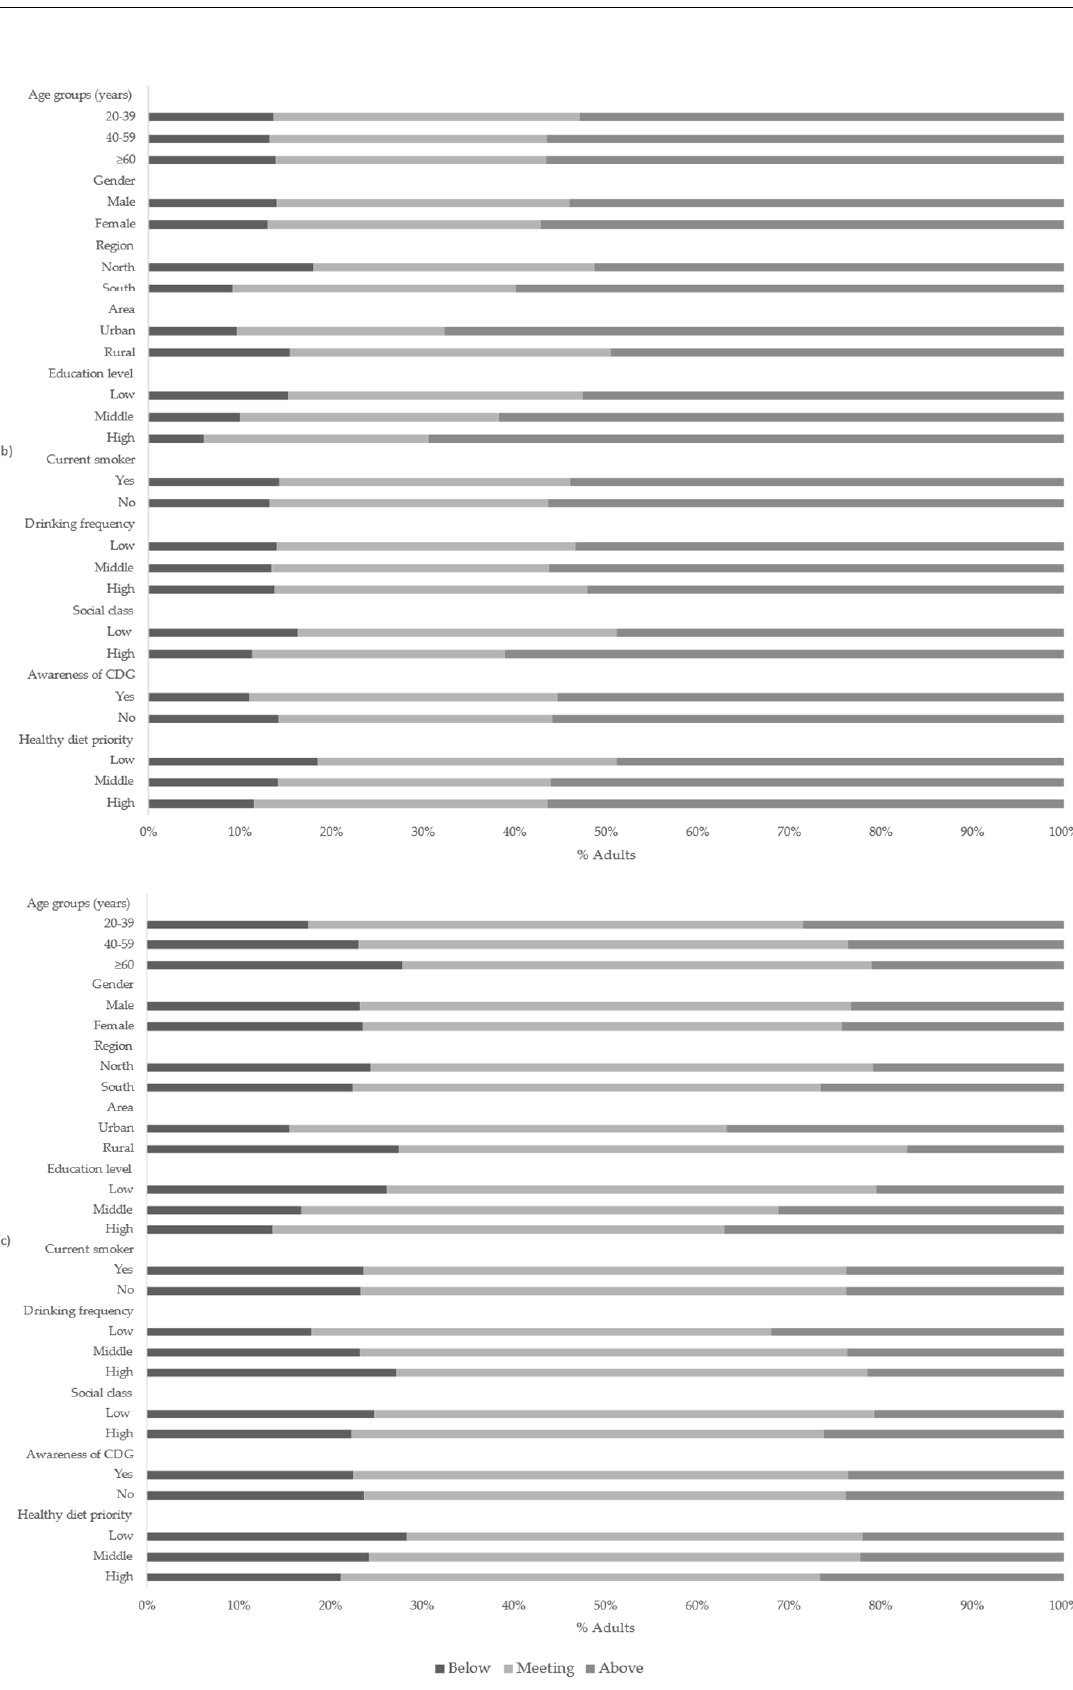
Figure 1. Percentage of adults with macronutrient intake below/meeting/above the recommended intake of DRI: ( a ) carbo- hydrates; ( b ) fats; ( c )